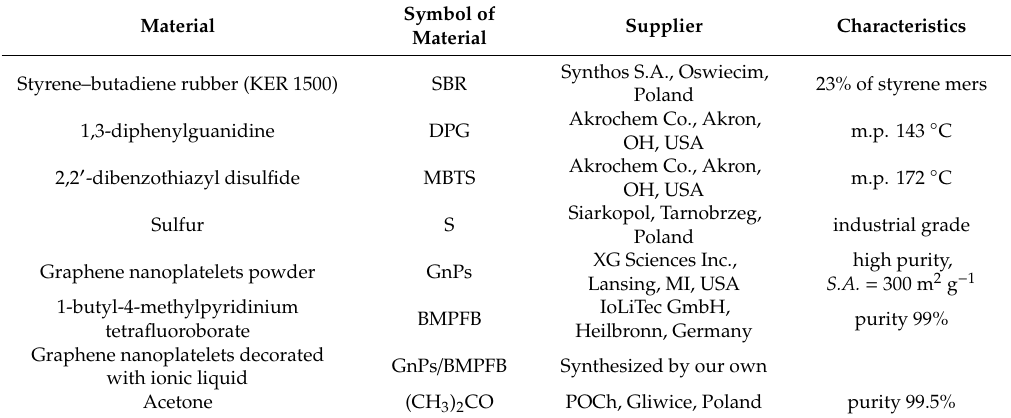
Table 1. Characteristics of the materials